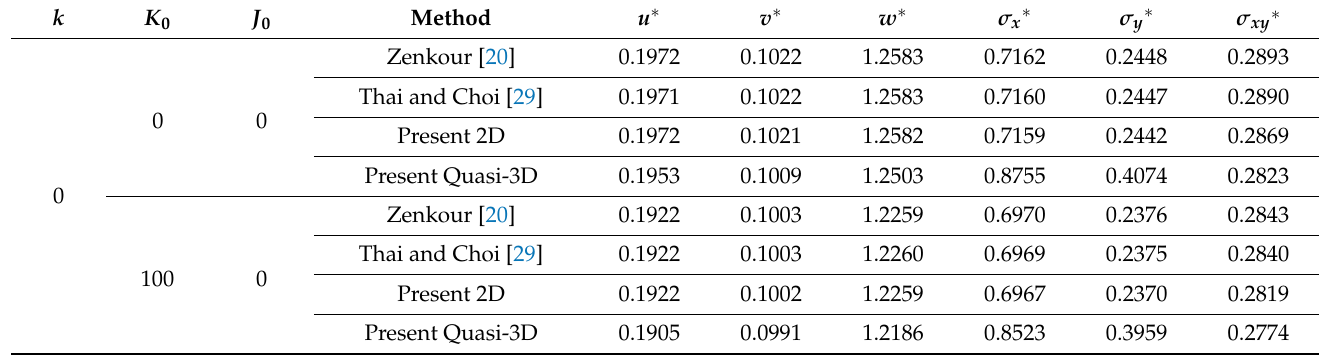
Table 9. Comparisons of non-dimensional displacements and stresses of simply supported